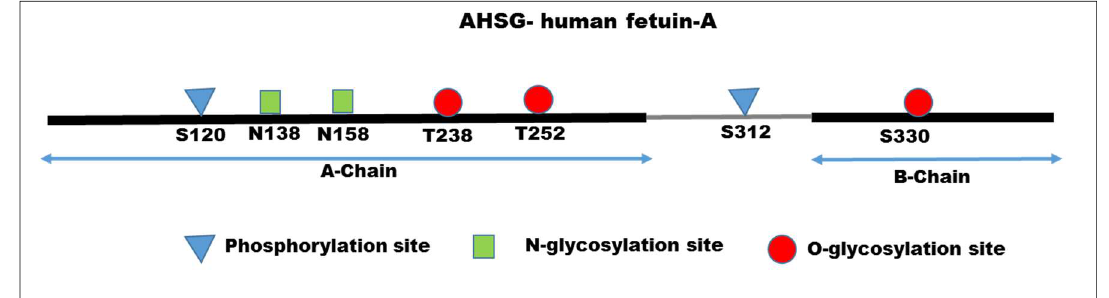
Figure 1. Amino acid sequence of human fetuin-A. The mature form of AHSG consists of A-chain (residues 1–282); connecting peptide (grey line) residues 283–321; B-chain residues 323–349. There are two phosphorylation sites (residues S120 and S312); two N -glycosylation sites (N138, N158) and two O -glycosylation (T238, T252) sites in the A-chain. There is one O -glycosylation site in the B-chain (S330).